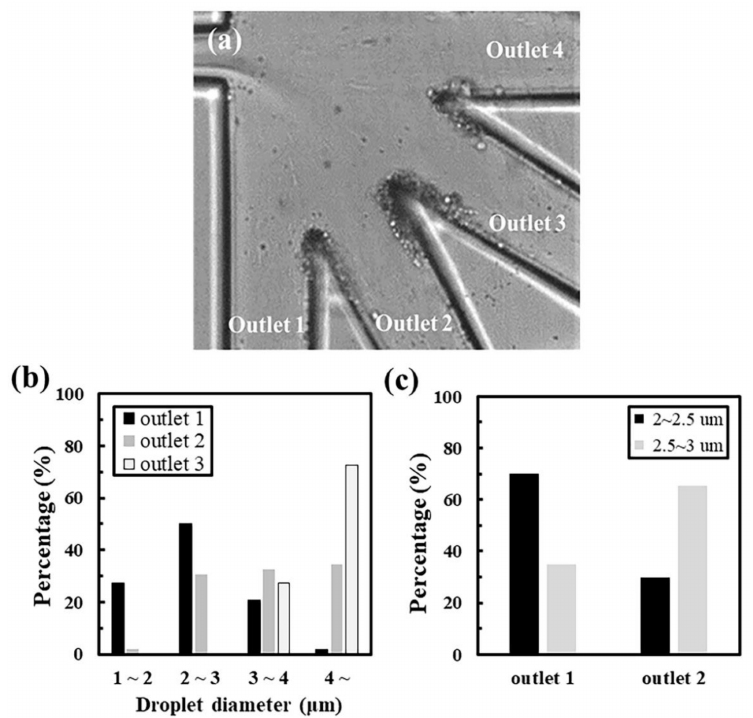
Figure 4. ( a ) A microscopic image of the sorting process in the pinched flow fractionation (PFF) microchannel, ( b ) Ag nanowire rings in dispersed solution from outlet 1, and ( c ) droplet diameters of the sorted droplets in outlets 1 and 2.